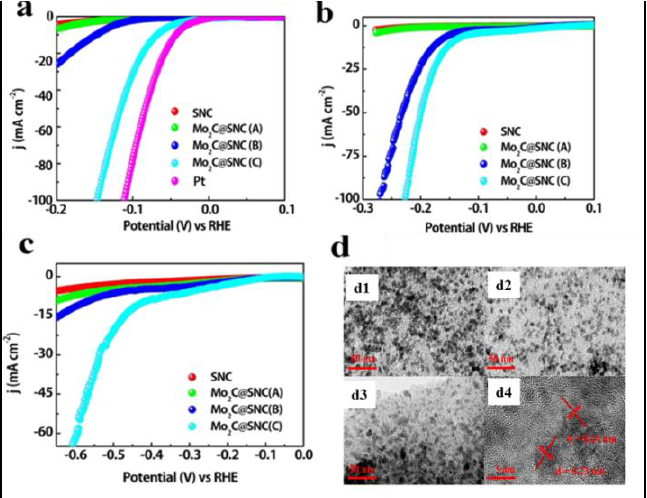
Figure 2. Polarization curves of sulphur-nitrogen-doped carbon (SNC) and Mo 2 C@SNC ( a ) in 1 M KOH; ( b ) in 0.5 M H 2 SO 4 ; ( c ) in a neutral PB (Phosphate Buffer) solution; ( d1 – d3 ) TEM image of Mo 2 C@SNC catalyst prepared using different Mo precursor concentrations; ( d4) high-resolution TEM image of one of the Mo 2 C@SNC catalysts. Reproduced from [67] with permission of the American Chemical Society 2020.